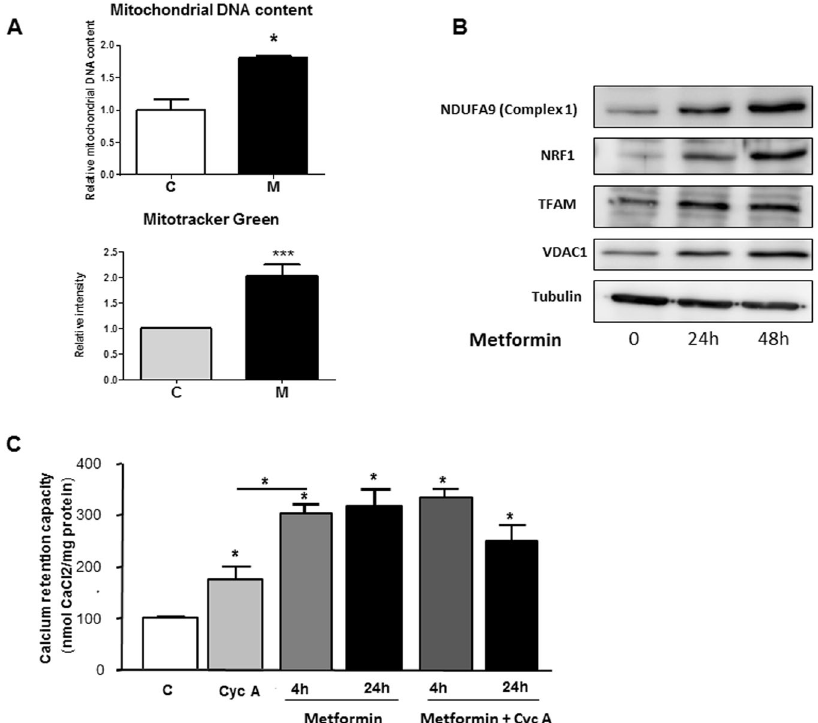
Figure 4. Metformin increases mitochondrial biogenesis in cancer cells and inhibits mitochondrial permeability transition pore. ( A ) Mitochondrial DNA content and quantification of MitoTracker Green in LNCaP cells treated with metformin for 24 h. The results were obtained from three independent experiments. p < 0.05 ( * ); p < 0.001 ( *** ). ( B ) Immunoblotting analyses of proteins and transcription factors implicated in mitochondrial function, after treatment with 5 mM metformin for 24 and 48 h. ( C ) Calcium retention capacity measured after the incubation of LNCaP cells with 1 µ M cyclosporin A for 4 h or 5 mM metformin for 4 h and 24